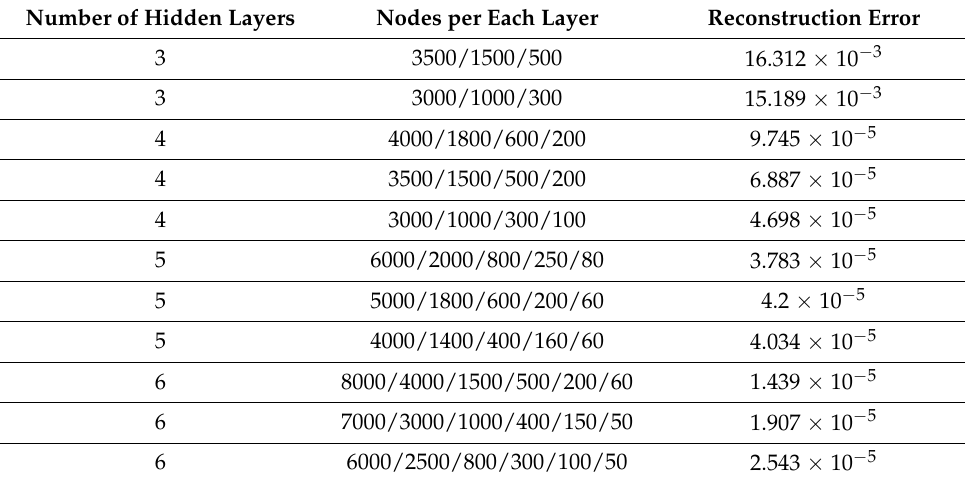
Table 3. The reconstruction error with the sets of numbers of hidden layers and their nodes.